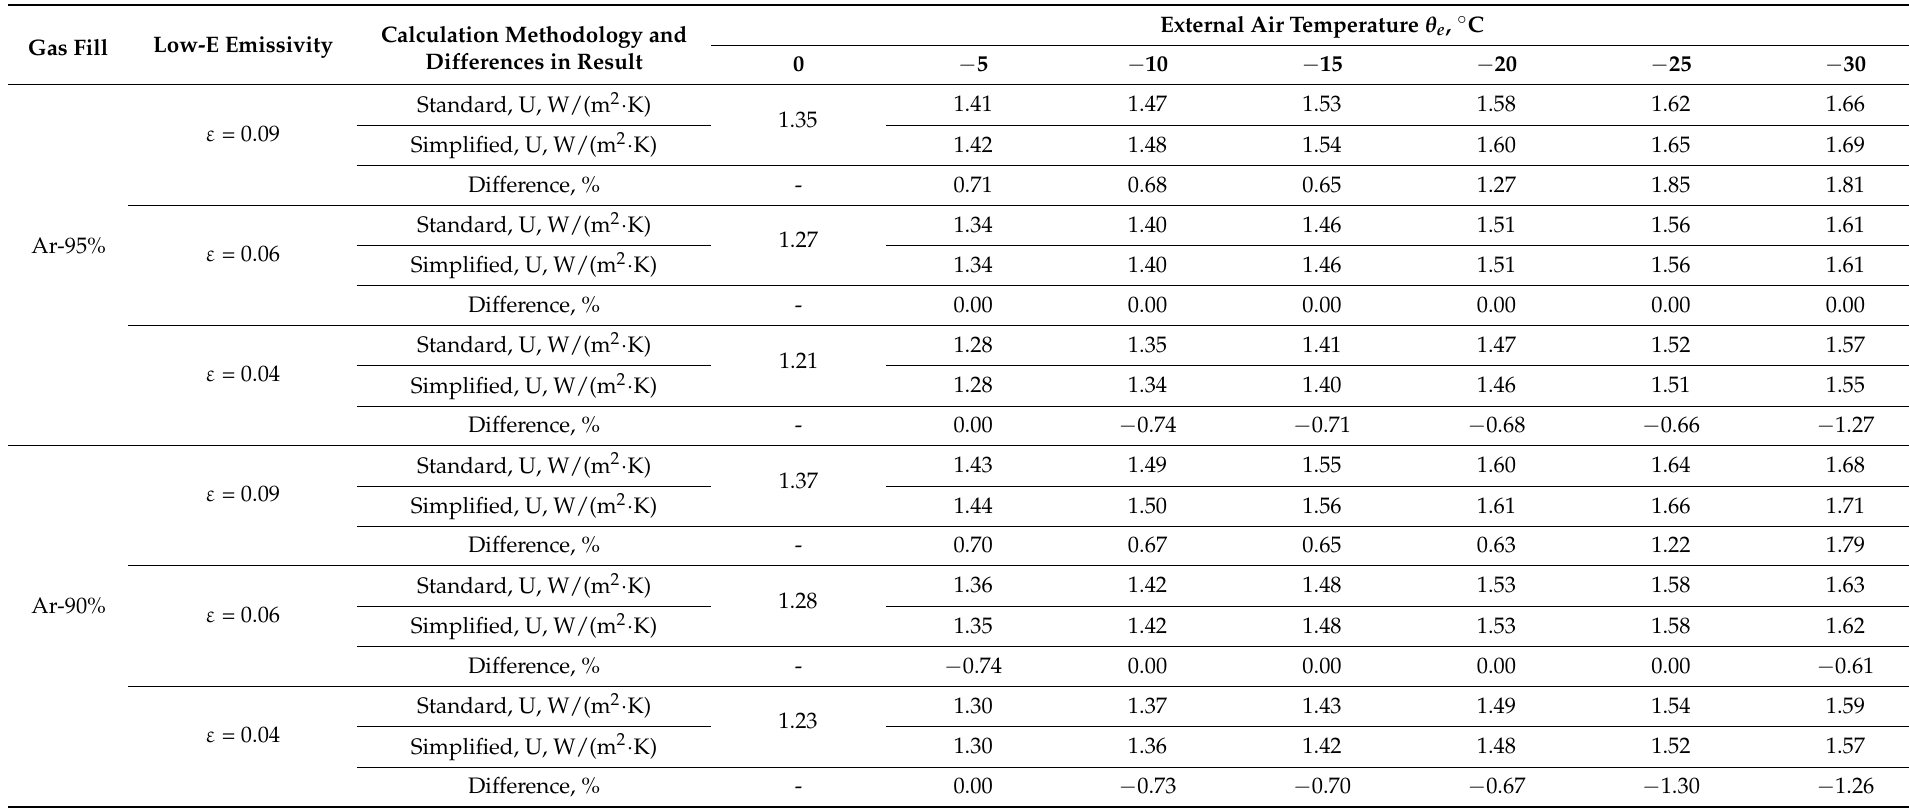
Table 8. The comparison of U-values of double-glazed 4-16Ar-4e IGU calculated according to the standard methodology and simplified